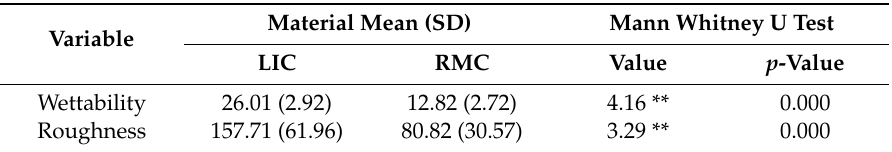
Table 7. Intergroup inferential analysis for the wettability and roughness parameters, depending on the type of material, with plasma etching surface